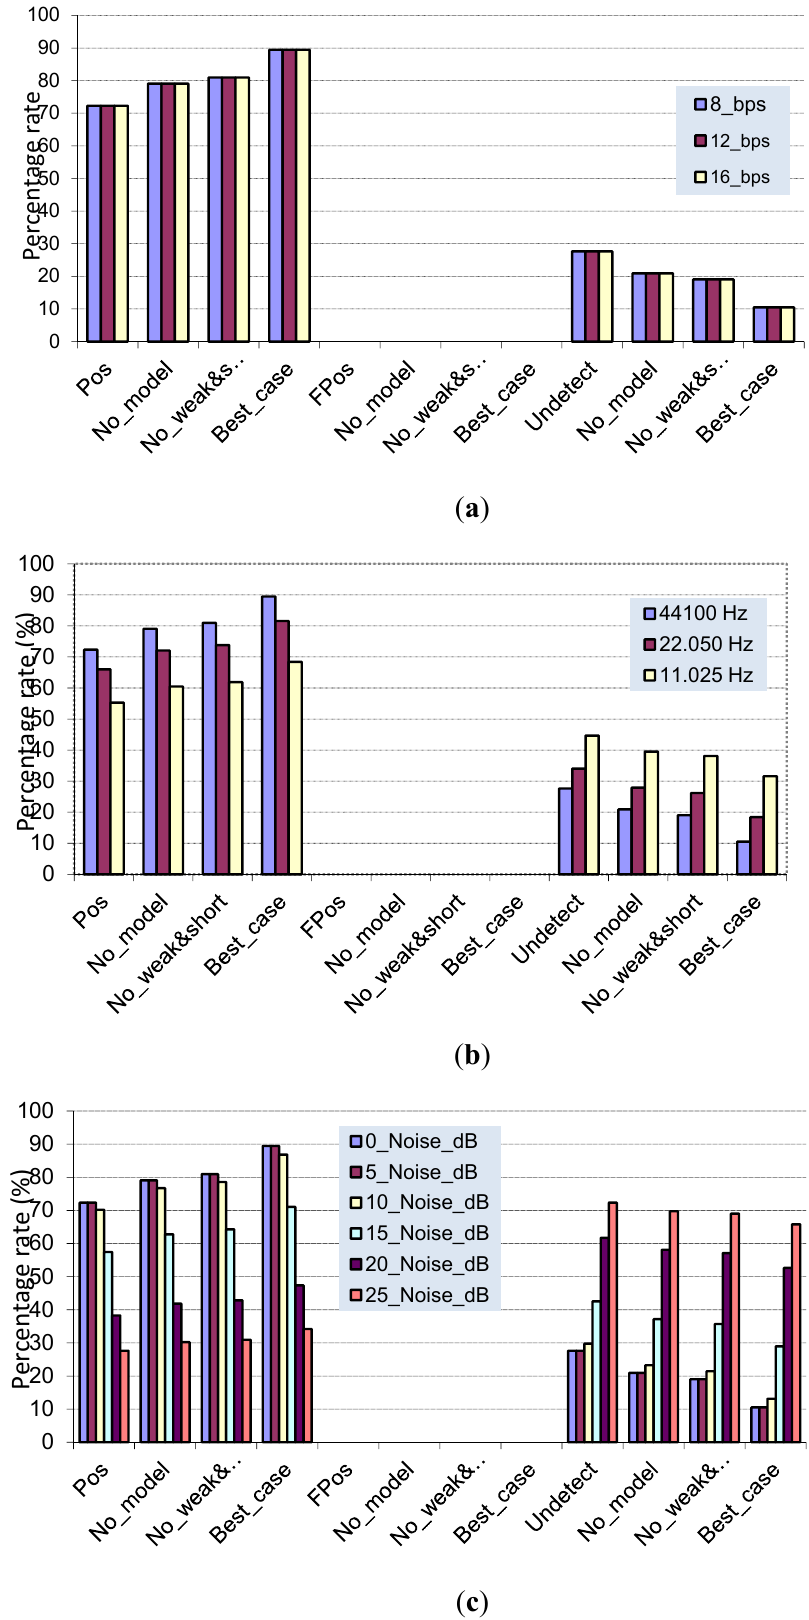
Figure 9. Detection performance under lower quality versions of the “*01.wav” audio